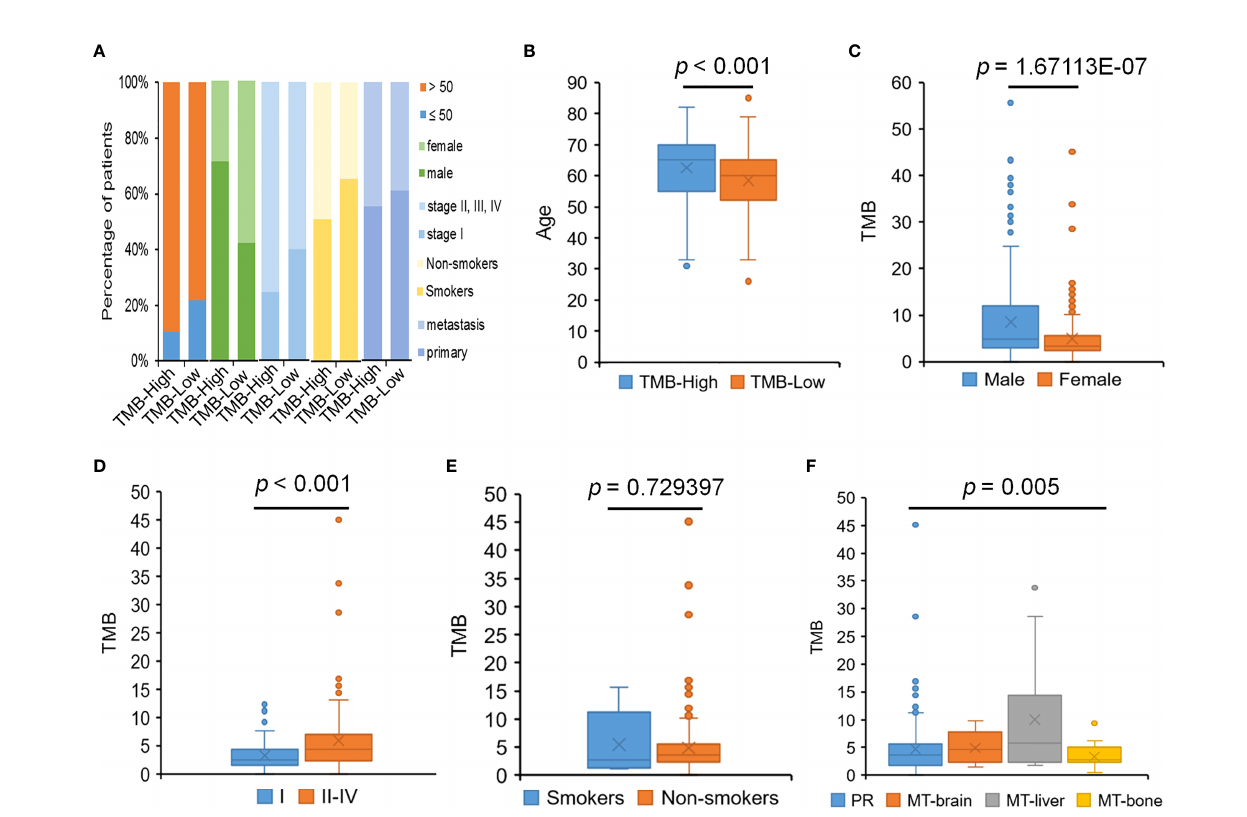
FIGURE 6 | The relationship between TMB and clinical features. (A) The percentage of patients with different clinical features in the TMB-High and TMB-Low groups. (B) The relationship between TMB and age. (C) The relationship between TMB and gender. (D) The relationship between TMB and pathological stages. (E) The relationship between TMB and smoking history. (F) The relationship between TMB and tumor